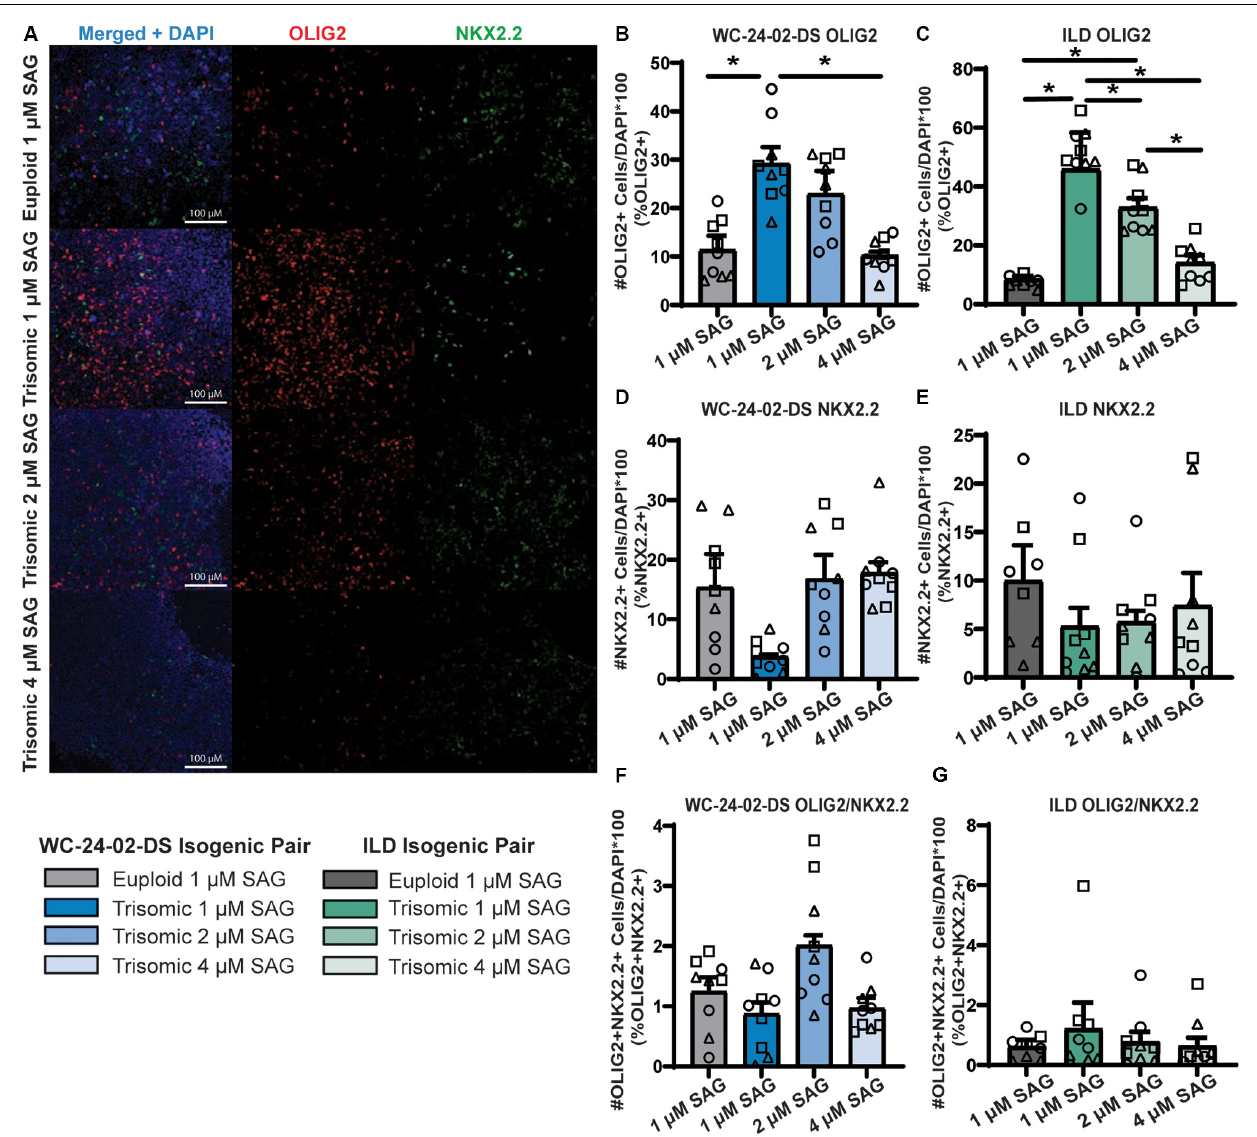
FIGURE 7 | Increasing SAG concentration normalizes expression of trisomic OLIG2 and NKX2.2. (A) Increasing the concentration of SAG in the trisomic cultures from 1 µ M to 2 µ M and 4 µ M changes the expression level of OLIG2 and NKX2.2 from their baseline expression in trisomic cultures. (B,C) Increasing the concentration of SAG decreases the percentage of cells expressing Olig2 in the WC ts and ILD ts trisomic lines. (D,E) Increasing the concentration of SAG increases the percentage of cells expressing Nkx2.2 in the WC ts and ILD ts trisomic lines. (F,G) Increasing the concentration of SAG does not change the percentage of trisomic cells co-expressing both OLIG2 and NKX2.2, n = 3, three independent differentiation experiments for all IHC measurements with values for individual wells overlaid. Note that the 1 µ M data is the same as Figure 3 and was performed independently from the 2 µ M and 4 µ M data. Data are shown as mean ± SEM. * p -value < 0.05 with specific values in